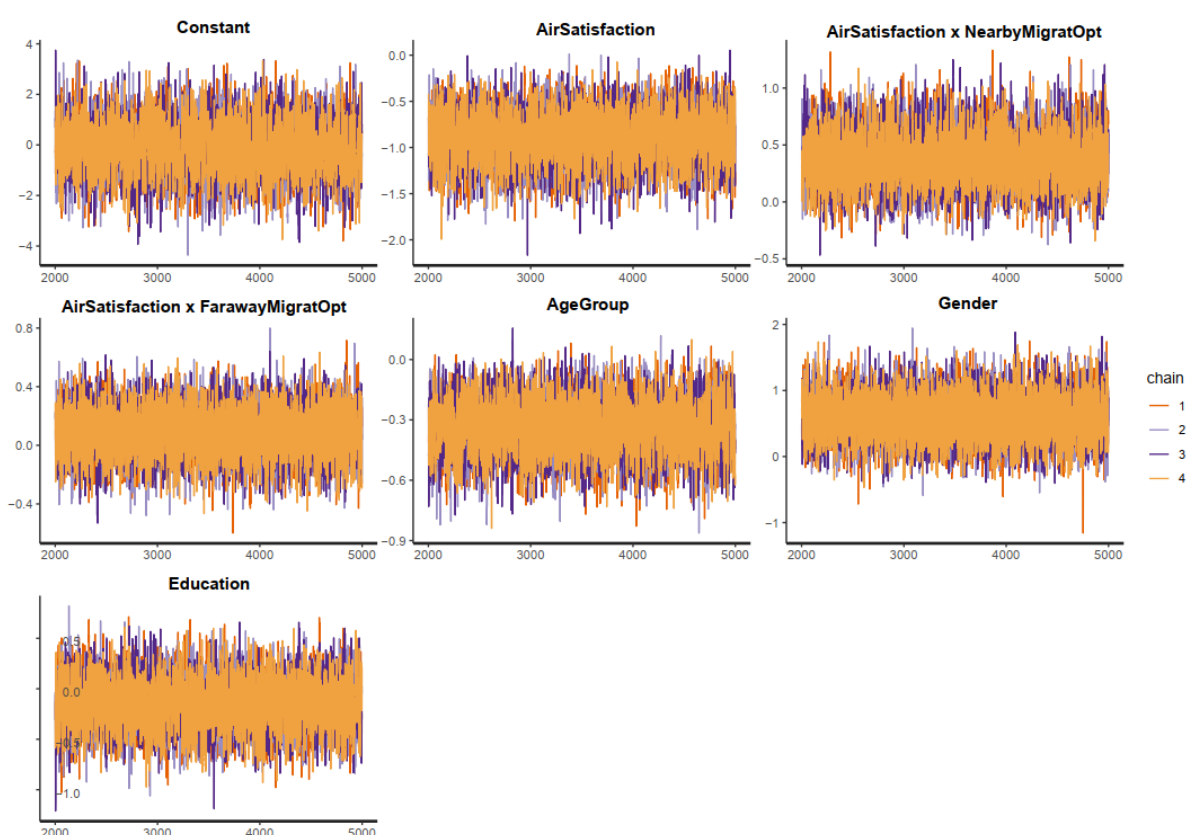
Figure 6. Model 2 ′ s PSIS diagnostic plot. Figure 6. Model 2 (cid:48) s PSIS diagnostic plot.